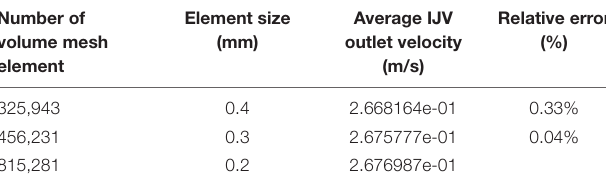
TABLE 1 | Mesh independence